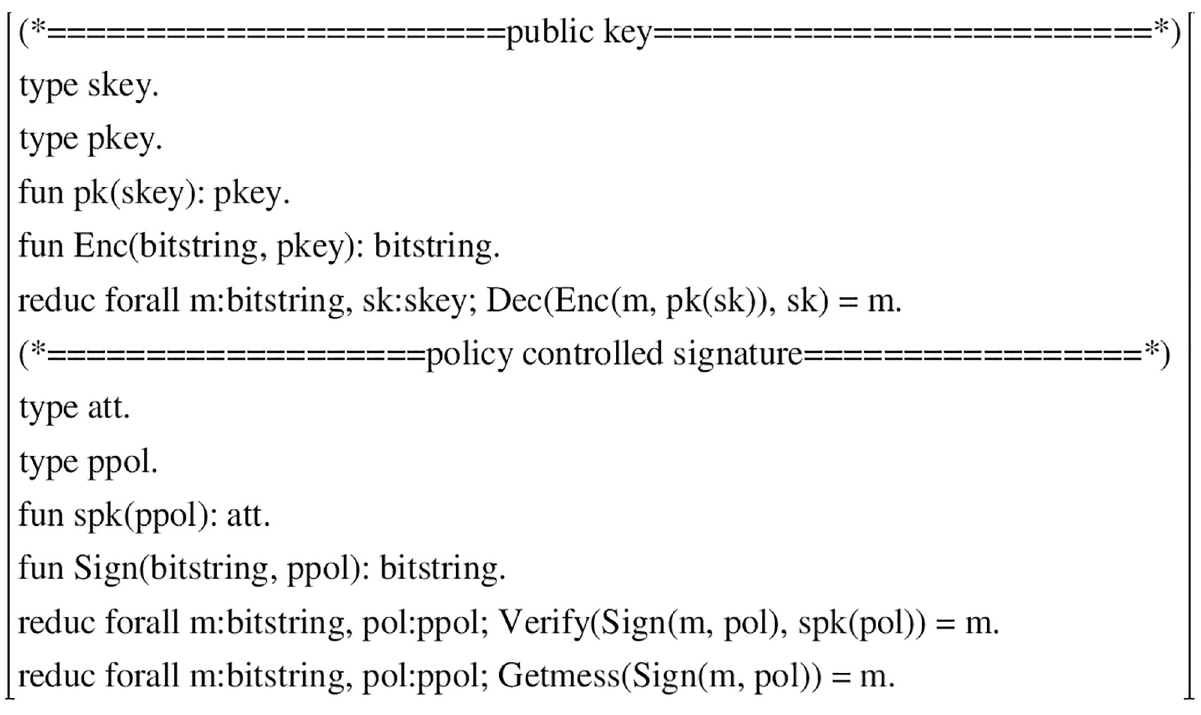
Fig 12. The functions and the equational